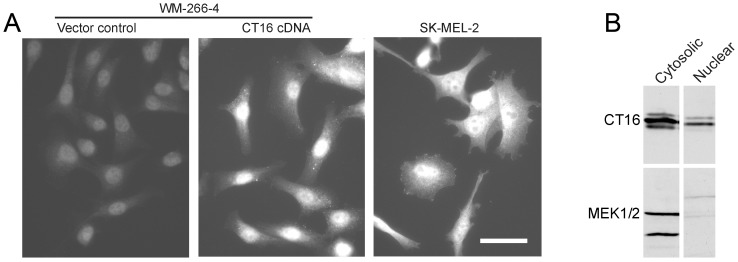
CT16 expression and location in cultured melanoma cells.(A) Images of indicated human melanoma cell lines labeled with rabbit polyclonal antibody against human cancer testis antigen protein CT16 followed by secondary antibody Alexa Fluor 488 goat anti-rabbit IgG (H & L). Images were captured, at equal exposure times to qualitatively compare the expression of the CT16 antigen in the cell lines. Fluorescence intensity in WM-266-4 cells transfected with CT16 cDNA containing plasmid is similar to that of CT16-positive SK-MEL-2 cells. WM-266-4 cells transfected with empty vector shows merely background fluorescence. The scale bar represents 20 µm for all images. (B) Western blot of cytosolic and nuclear fractions of SK-MEL-2 cells. For detection of CT16, the samples were run on a 12% non-denaturing polyacrylamide gel, where CT16 usually migrates as two or three distinct bands. MEK1/2 was detected in the samples run on a 12% denaturing polyacrylamide gel.